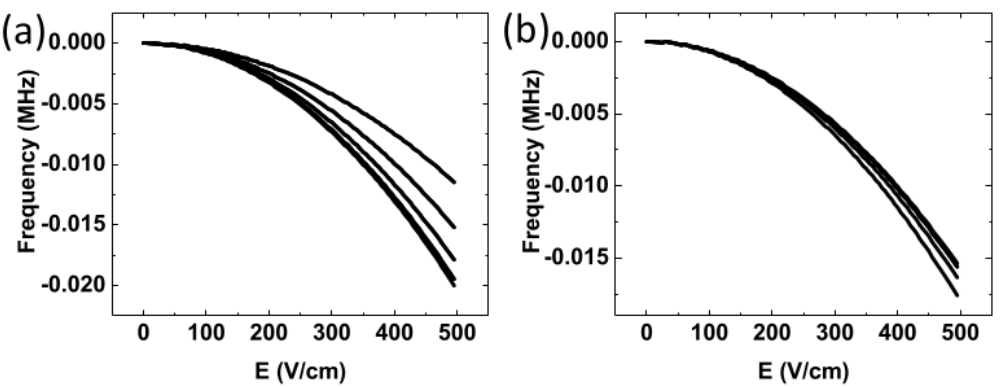
Figure 3. ( a ) the frequency shift between the 5 2 P 3/2 F = 4 state and the 5 2 S 1/2 F = 3 state under an electric field, or the Stark effect of the trapping transition of the 85 Rb atoms; ( b ) the Frequency shift between the 5 2 P 3/2 F = 3 state and the 5 2 S 1/2 F = 2 state under an electric field, or the Stark effect of the repump transition of the 85 Rb atoms. In both plots, we shift the zero field energy difference to